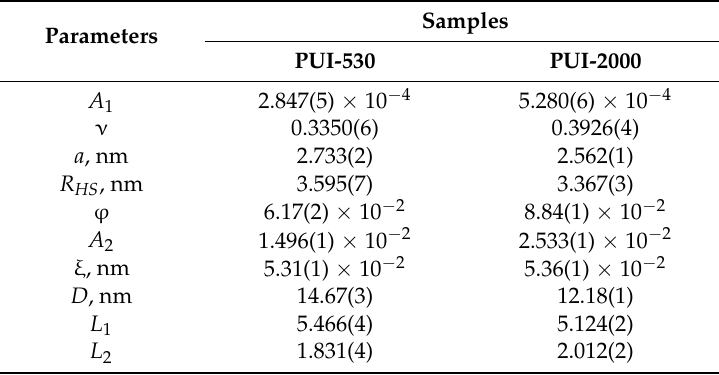
Table 1. Fitting parameters of the small-angle X-ray scattering (SAXS) curves and structural parameters of